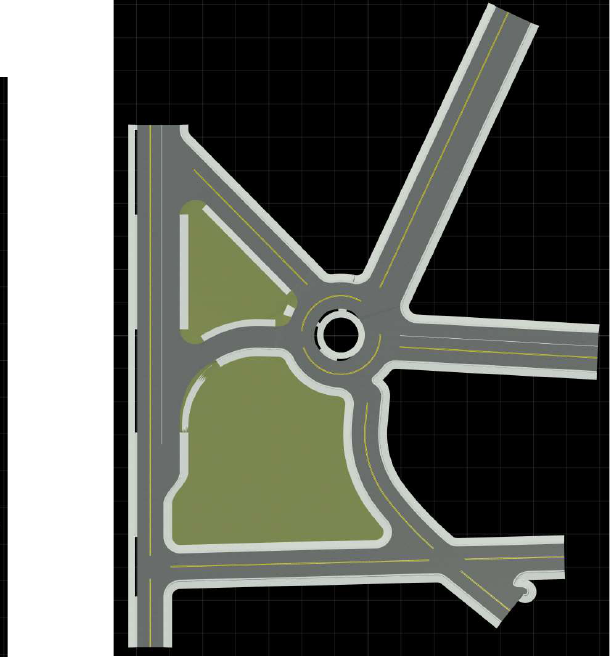
Figure 5. Sample synthetic cases